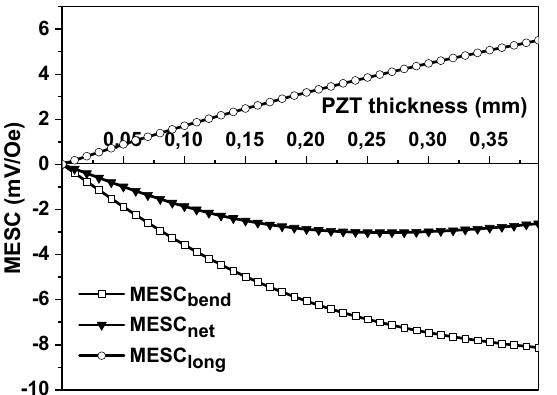
Figure 10. Estimated dependence of MESC in a Ni-Permendur-PZT second-type three-layered structure on the PZT layer thickness. The Ni layer thickness t m 1 = 0.2 mm, the Permendur thickness t m 2 = 0.15 mm.